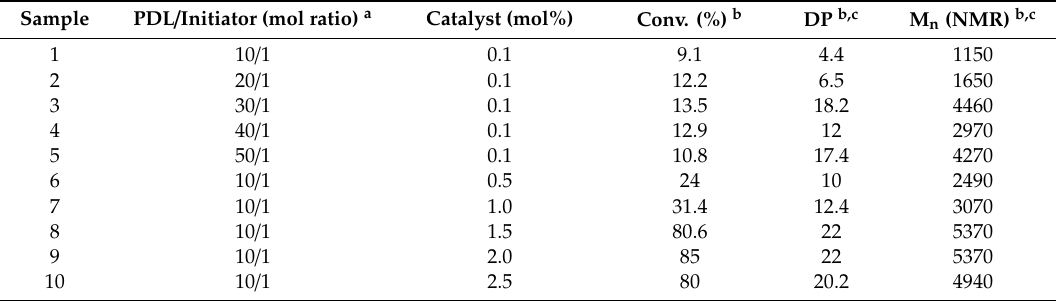
Table 2. The applied PDL / initiator ratio, catalyst amount, obtained conversion, polymerization degree, and molecular weight determined by NMR of PDL polymerization.